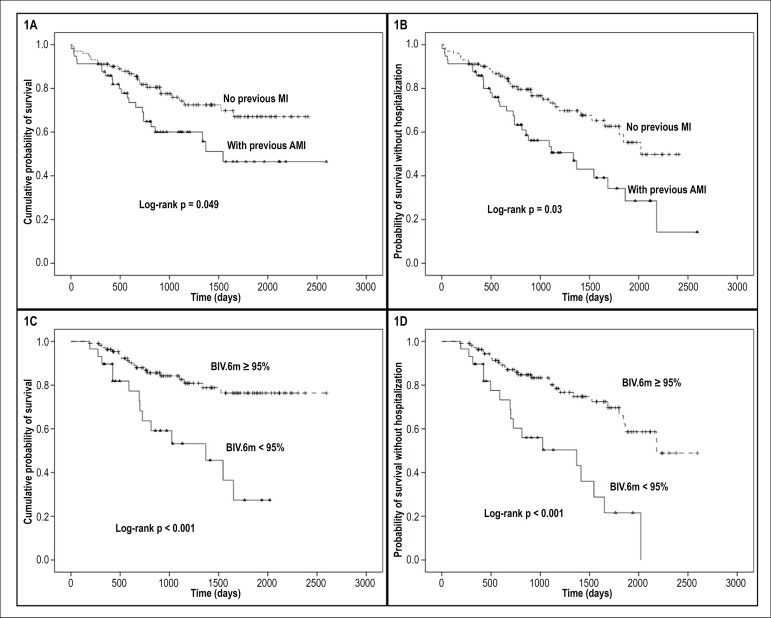
Kaplan-Meyer curve of total mortality (A) and total survival free of
death or hospitalization (B) stratified by presence of AMI and total
mortality (C) and total survival free of death or hospitalization
(D) stratified by the presence of biventricular pacing greater than
or equal to 95%.